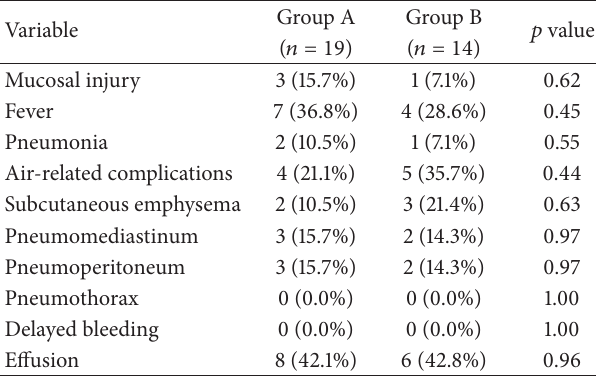
Table 4: (a) Comparison of symptom relief (by Eckardt). (b) Preop- erative and postoperative IRP and LESP Comparison (mmH 2 O).